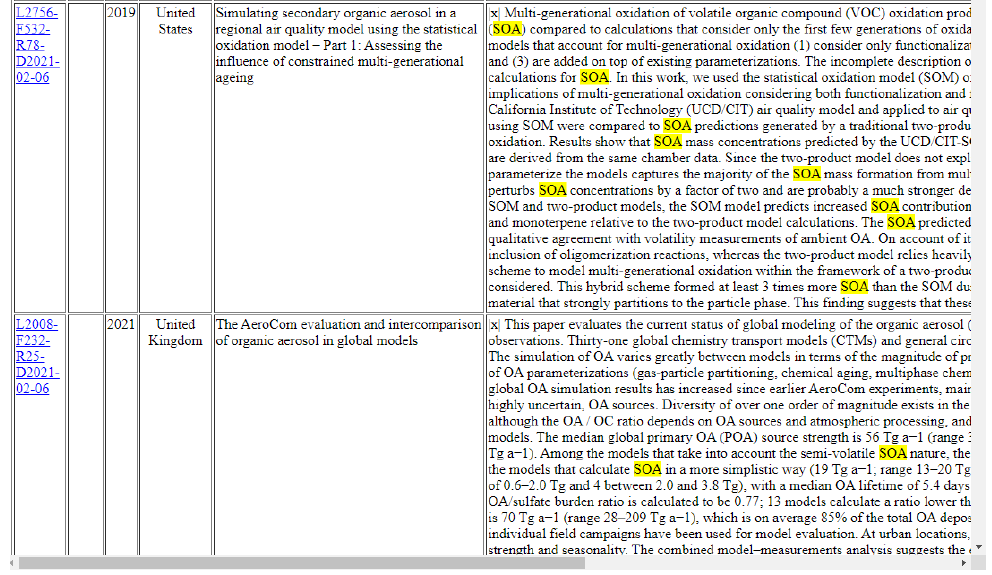
Figure 8. Paper abstract output sample for the SOA topic.